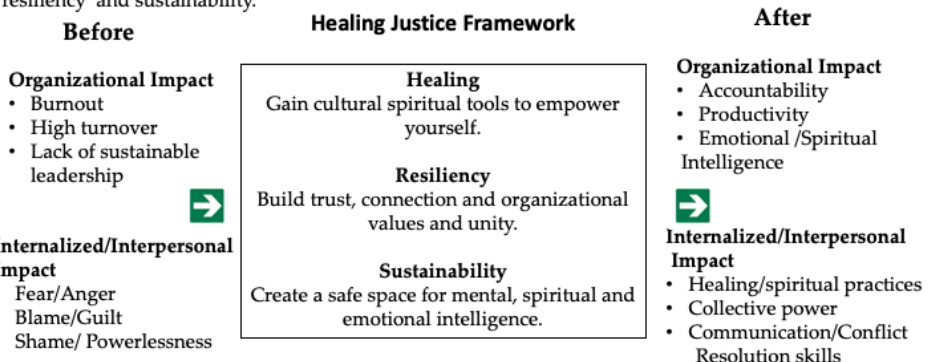
Figure 1. The healing justice framework uses a multiprong approach to address the fact that survivors are workers and leaders within organizations and the major impact that GBV has on the personal and the organizational system. Bridging healing and social justice supports women in leadership in ( a ) telling their story of violence and trauma, ( b ) identifying the impact of trauma on their mind, body, and spirit, ( c ) identifying how GBV has shaped the way they lead, and ( d ) learning healing and spiritual practices that will sustain their leadership and organizations beyond funding.